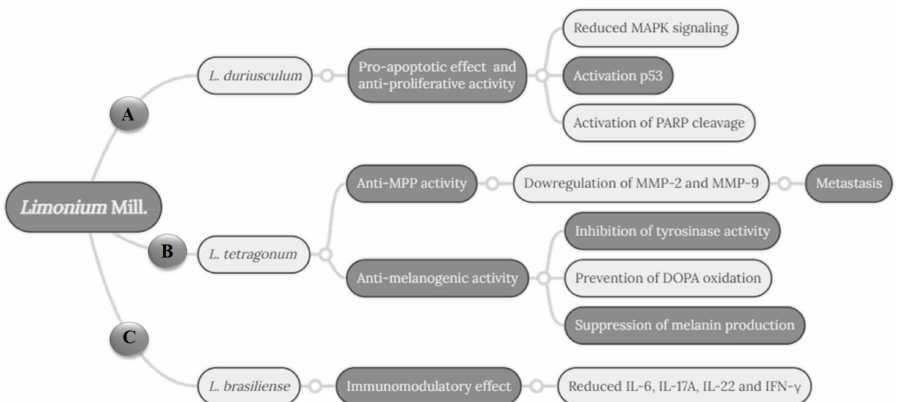
Figure 3. The possible cellular mechanism involved in the anti-cancer activity of Limonium species included in the systematic review. ( A ) Cell proliferation inhibition pathways mediated by L. duriusculum extract. ( B ) Inhibition of matrix metalloproteinases (MMP-2 and 9), Zn dependent endoproteases related to various complications in cancer, such as metastasis, and anti-melanogenic activity linked to inhibition of melanin biosynthesis mediated by bioactive compounds of L. tetragonum . ( C ) Immunomodulatory activity related to reduced of interleukin (IL) 6, 17A, and 22, and interferon-gamma (IFN- ϒ ) mediated by L. brasiliense crude extracts and fractions, suggesting an anticancer effect of this species. Note: Adapted from Hamadou et al. [37]; Bae et al. [31]; Lee et al. [34]; Cordeiro